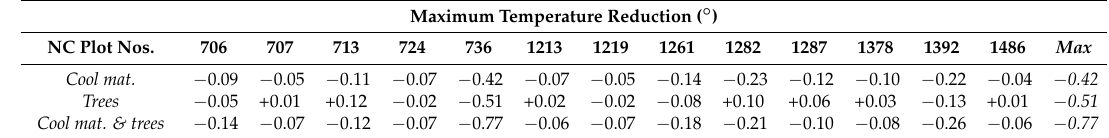
Table 2. Results of simulations for selected NCs in Bachoura District. Maximum air temperature difference from 0 to 5 m above ground before and after the application of mitigation strategies. Maximum Temperature Reduction ( ◦ ) NC Plot Nos.